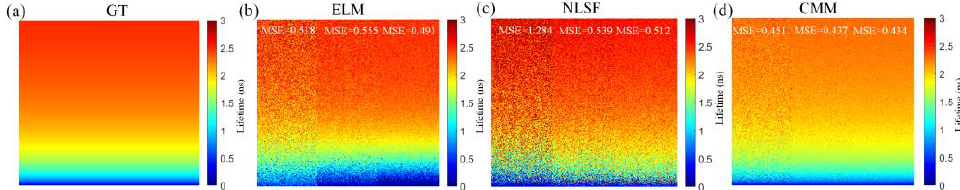
Figure 6. ( a ) GT τ I image in exact ranges. ( b – d ) Reconstructed τ I images from ELM, NLSF, and CMM for bi-exponential decays.